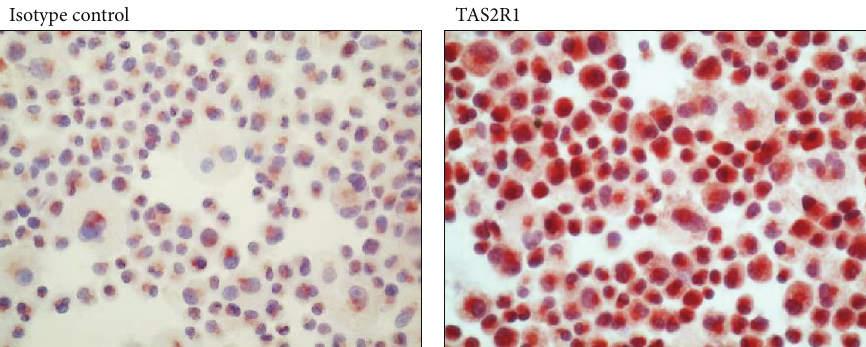
Figure 5: Immunocytochemical staining against TAS2R1. The human mast cell line LAD-2 was stained with an isotype control antibody or antibodies against TAS2R1.